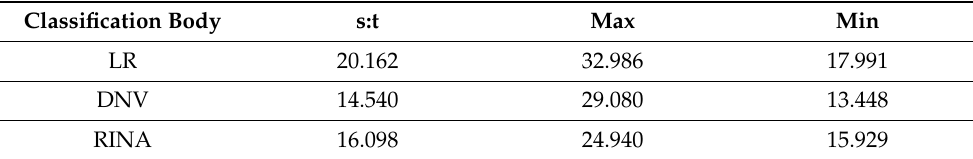
Table 1. Details of deck plate thickness used in the analysis.